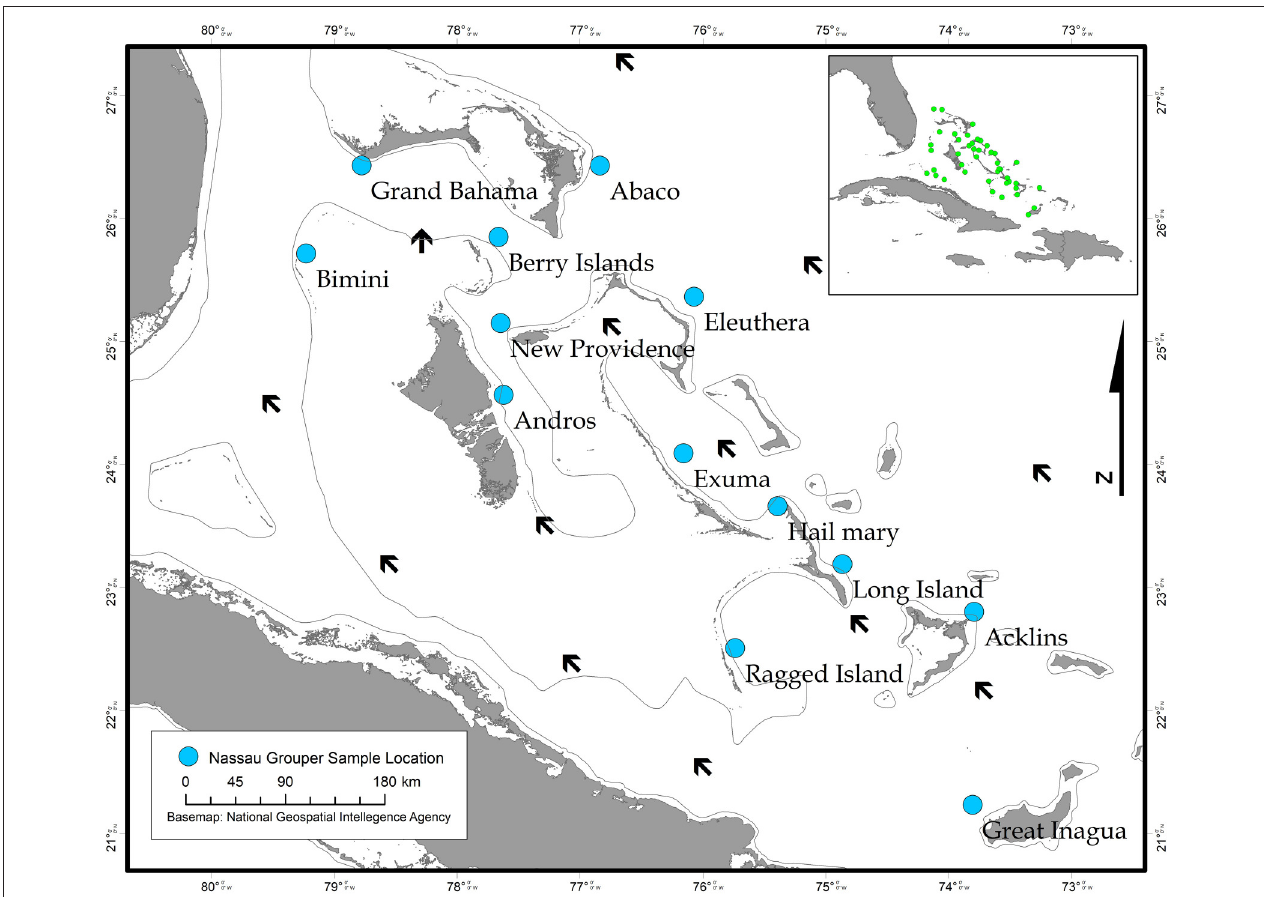
FIGURE 1 | Map showing sampling locations of Nassau grouper collected in The Bahamas (blue circles) and prevailing currents (black arrows), with an inset map depicting approximate locations of in-country Nassau grouper fish spawning aggregations (FSAs) (green circles).